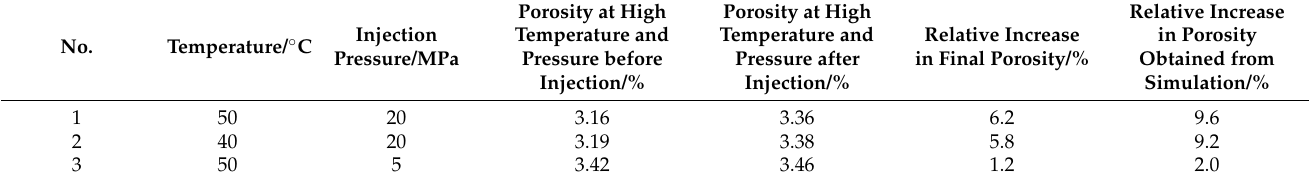
Table 4. Porosity changes before and after the experiment and numerical simulation.